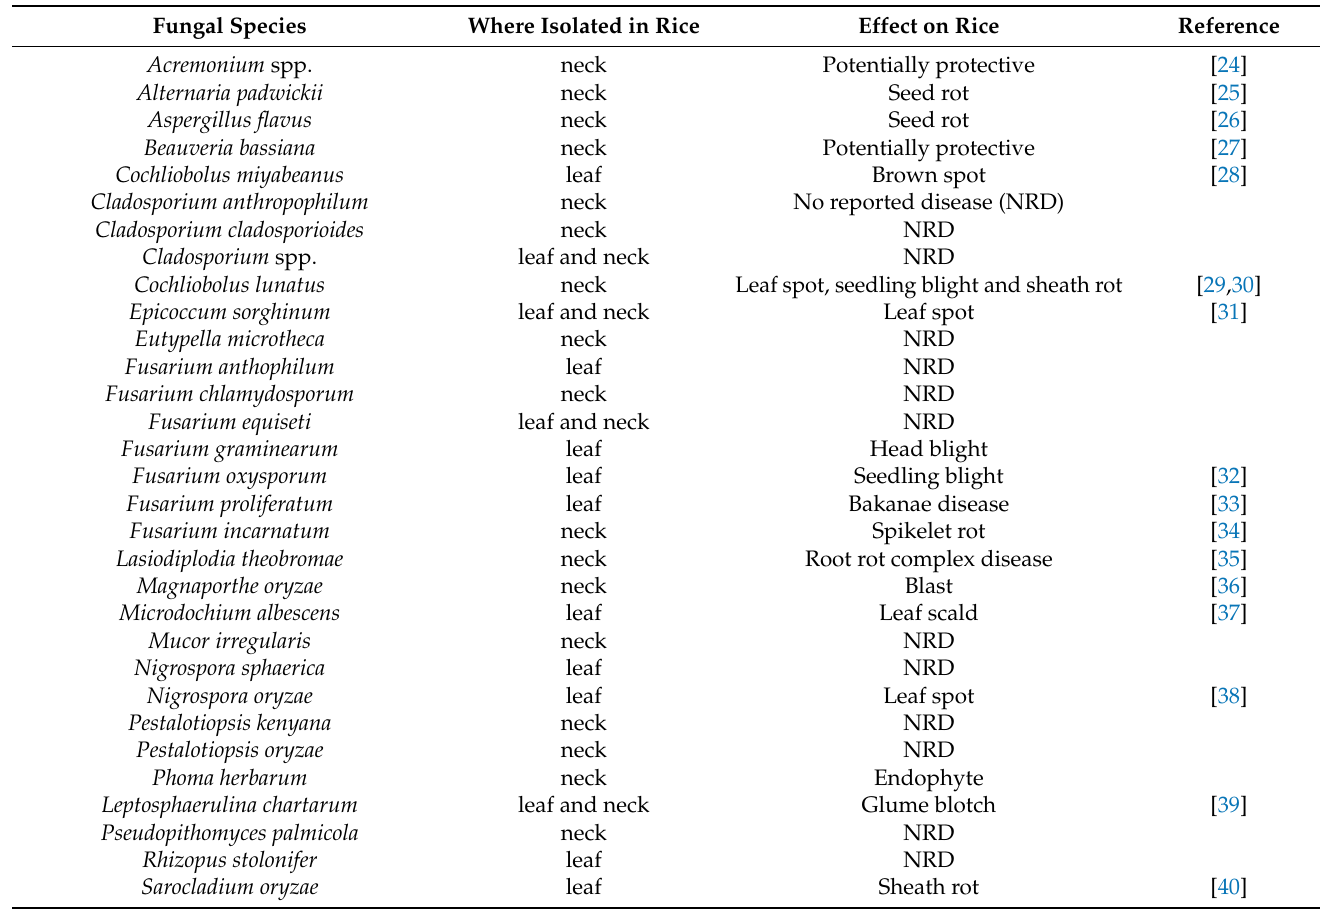
Table 5. Fungal species identified in leaf and neck-tissue samples and their potential relationships with rice